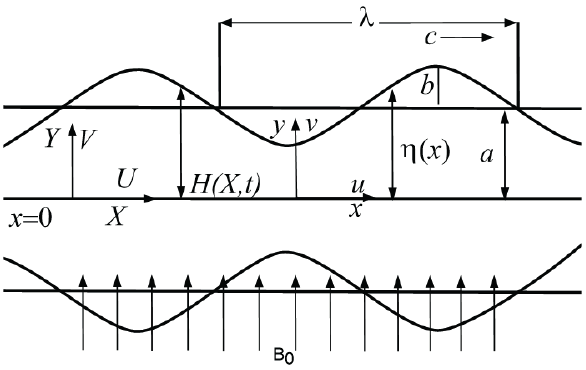
Fig. 1: Geometry of peristaltic channel flow.